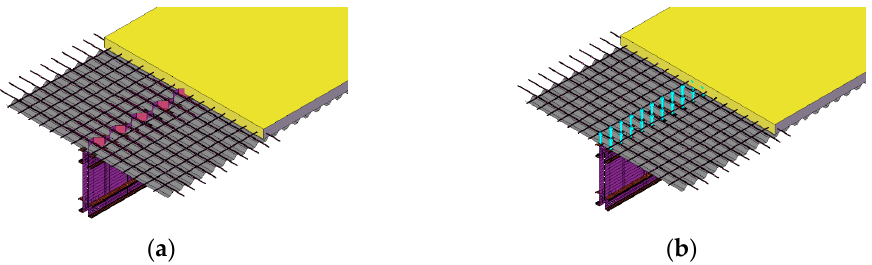
Figure 6. Proposed solutions for shear connection: ( a ) composite dowel rib connectors; ( b ) demountable headed shear stud connectors.